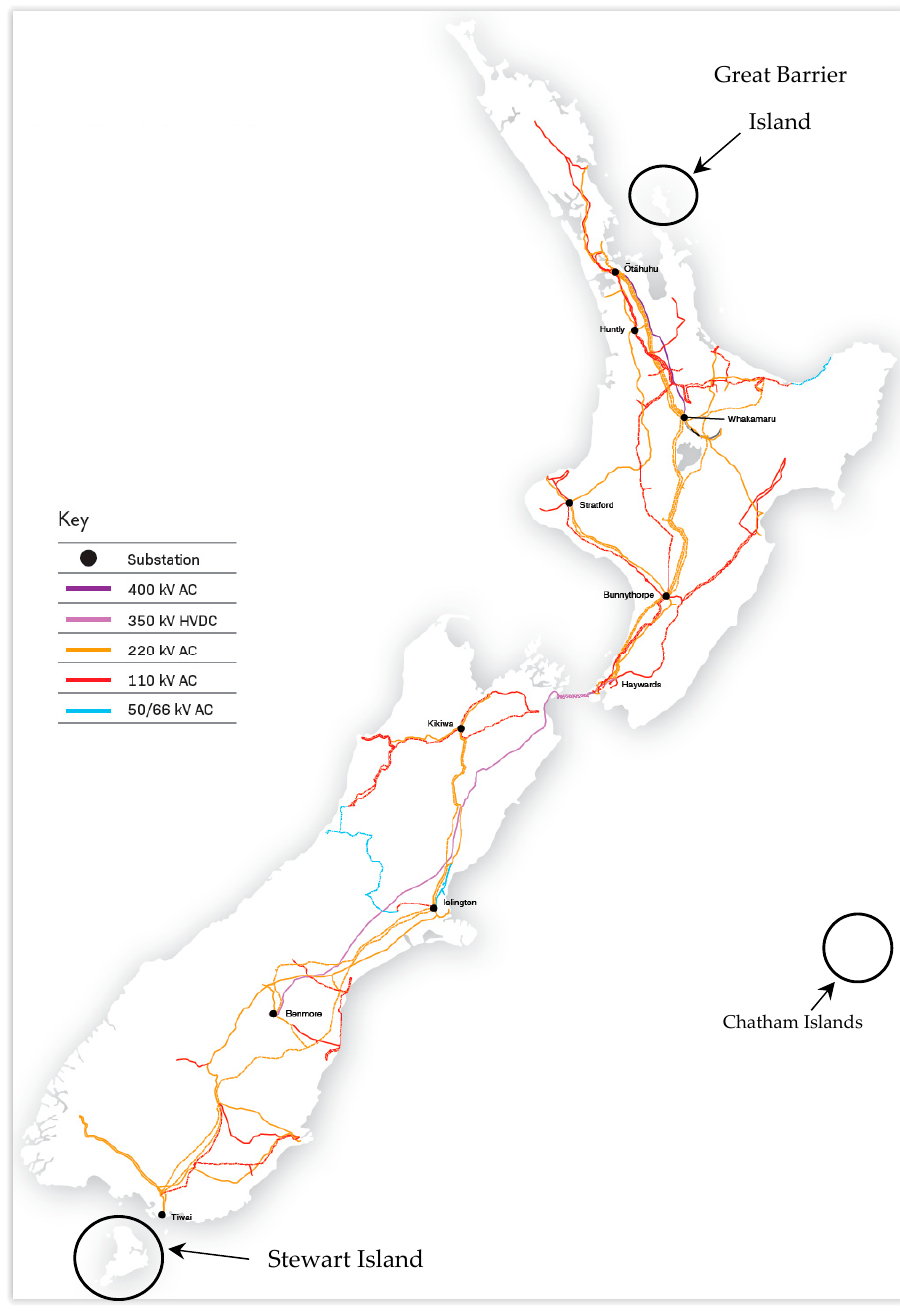
Figure 1. Transmission network map [14].